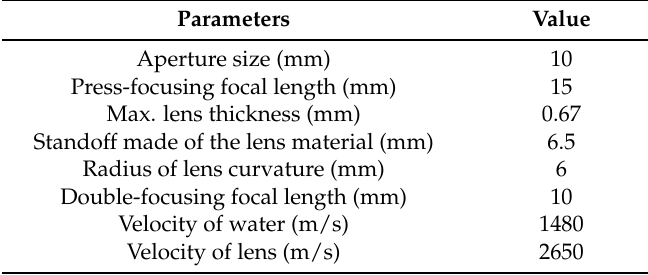
Figure 3. Conceptual illustration of a double-focused transducer in a cross-sectional view. Table 1. Geometric parameters and sound velocities of the media used for the design of the double-focused transducer.